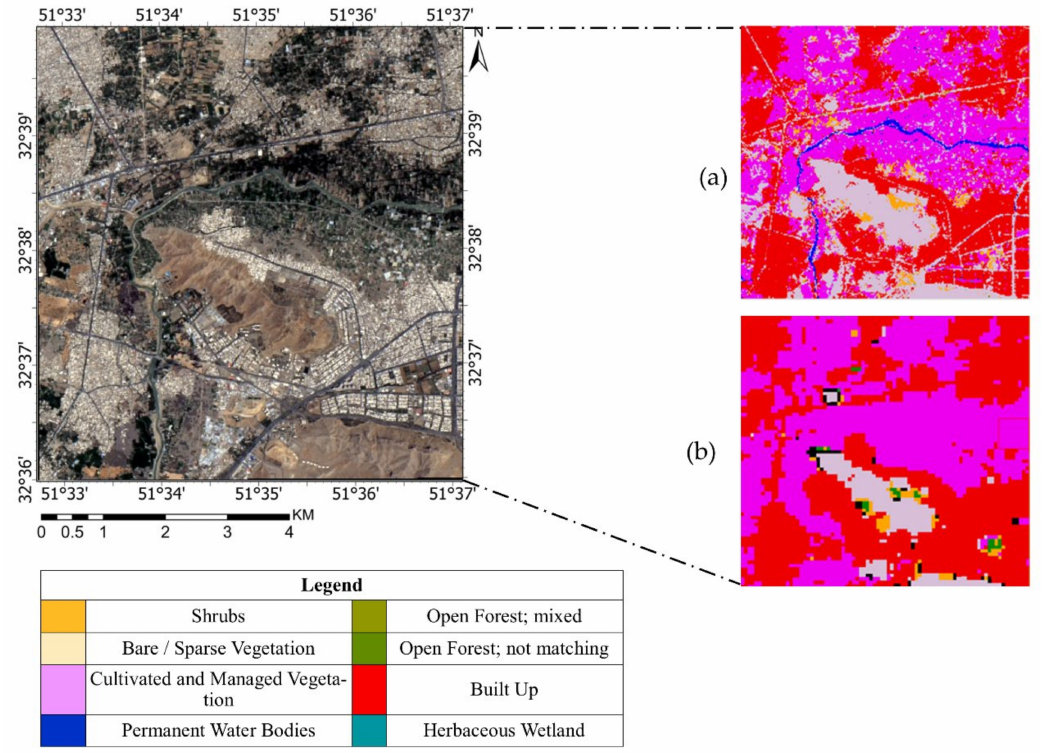
Figure 8. Comparison between our proposed method ( a ) and CGLCL map ( b ) in